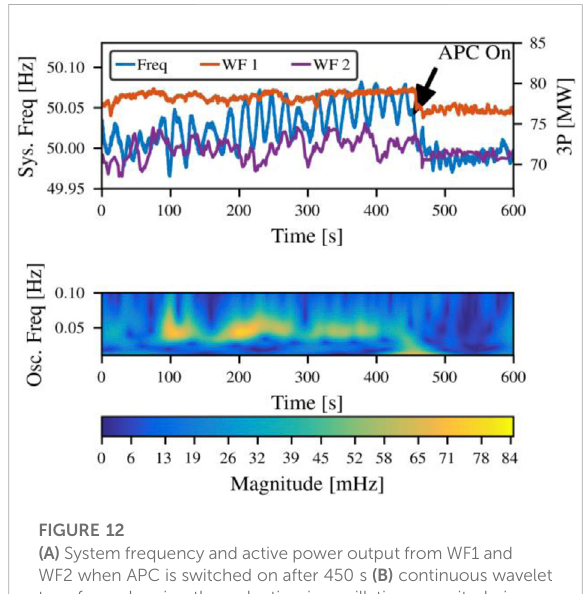
FIGURE 12 (A) System frequency and active power output from WF1 and WF2 when APC is switched on after 450 s (B) continuous wavelet transform showing the reduction in oscillation magnitude in system frequency for oscillation frequencies between 0.02 and 0.1